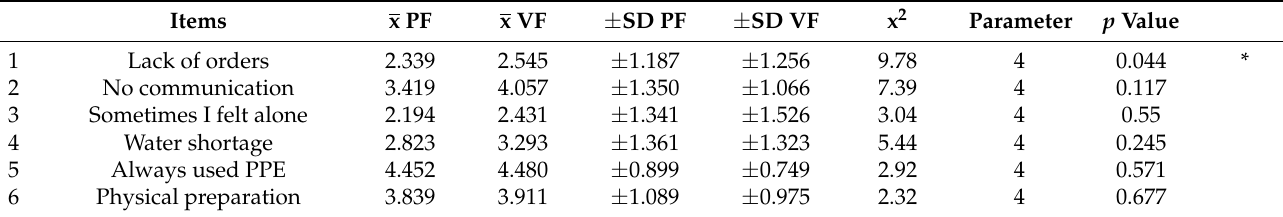
Table 8. At the front of flames, PF vs. VF ( n = 185).